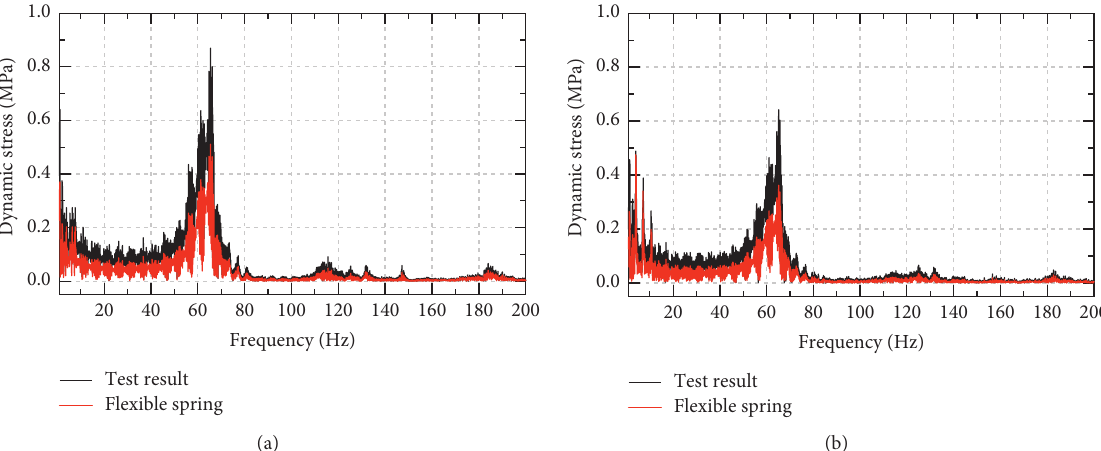
Figure 12: Comparison of dynamic stress between simulation and experiment. (a) 1.2 circle positions of spring. (b) Middle circle positions of